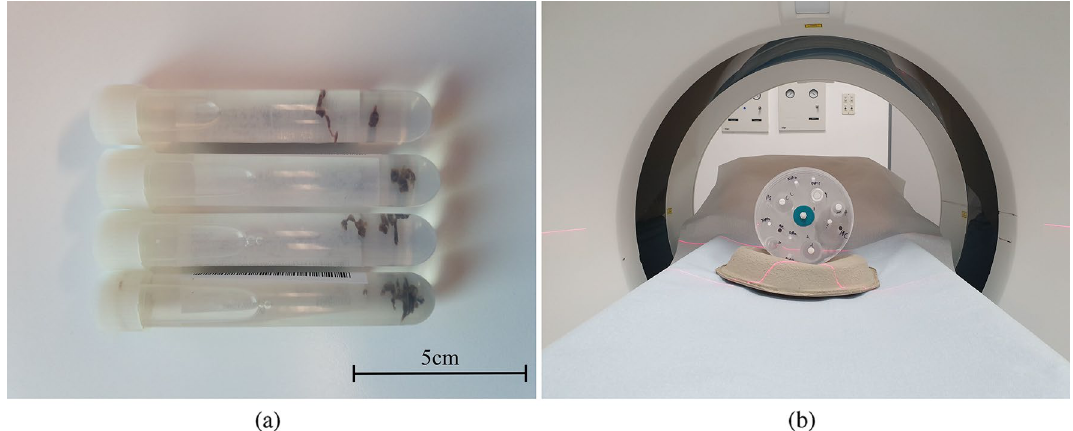
Figure 1. ( a ) Illustration of the basic measurement setup, showing clots stored in tubes filled with formalin after they were extracted from the patient by mechanical thrombectomy and immediately fixated with formalin. ( b ) For the measurement, two of these tubes can be inserted and measured by the dual-layer CT using a specimen holder. The specimen holder itself was placed on a cardboard tray to prevent the holder from moving during the measurement and to create a slightly inclined plane so that the clots remain at the bottom of the tubes.